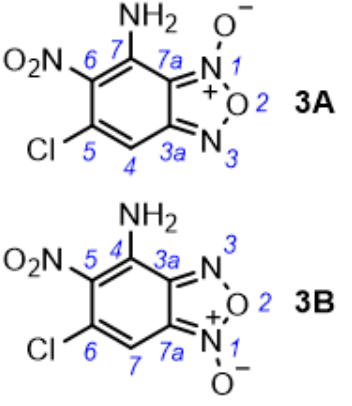
Figure 5. Structures and atoms numbering of tautomers 3A and 3B .